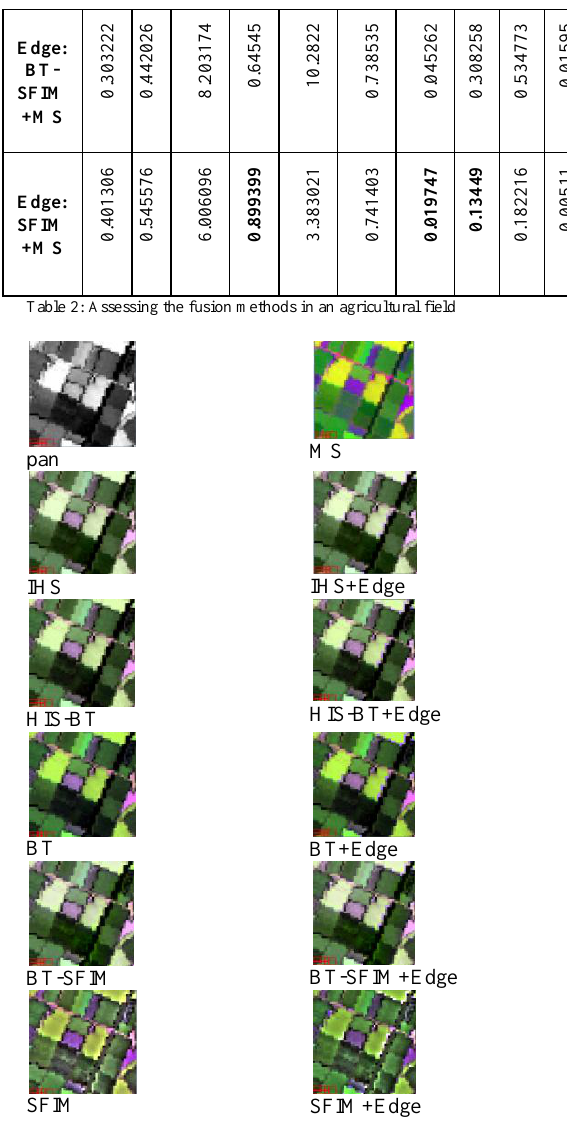
Figure 2: Results for Agricultural